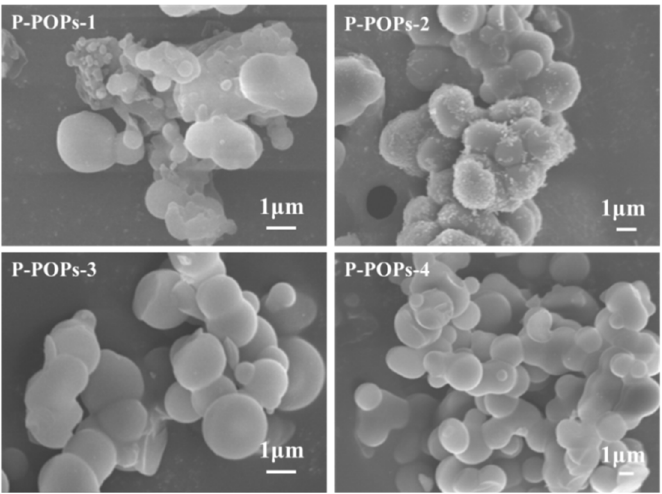
Figure 3. The SEM images of P-POPs.